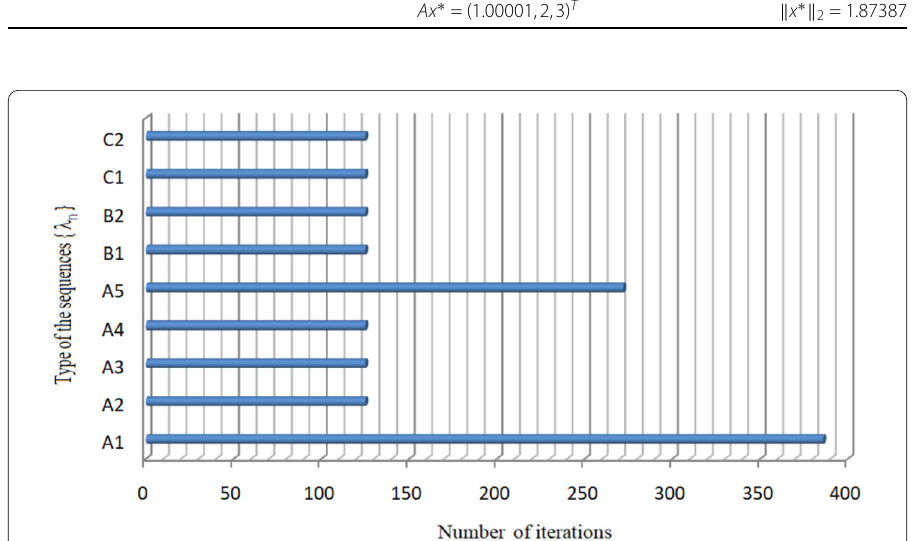
Figure 7 Benchmark for all choice types of the sequences { λ n } in Example